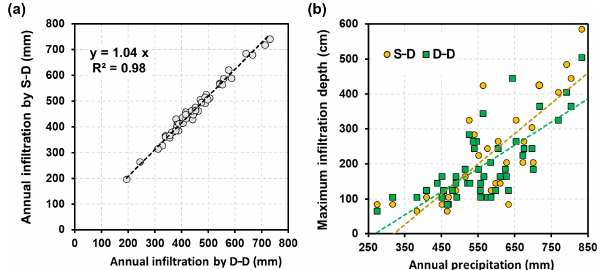
Figure 11. Profile of (a) fine-root density distributions (%) and (b) root water uptake distributions (mm) resulting from different ap- proaches (the S–D and D–D approaches). The error bars represent the standard error (SE) of the mean of different